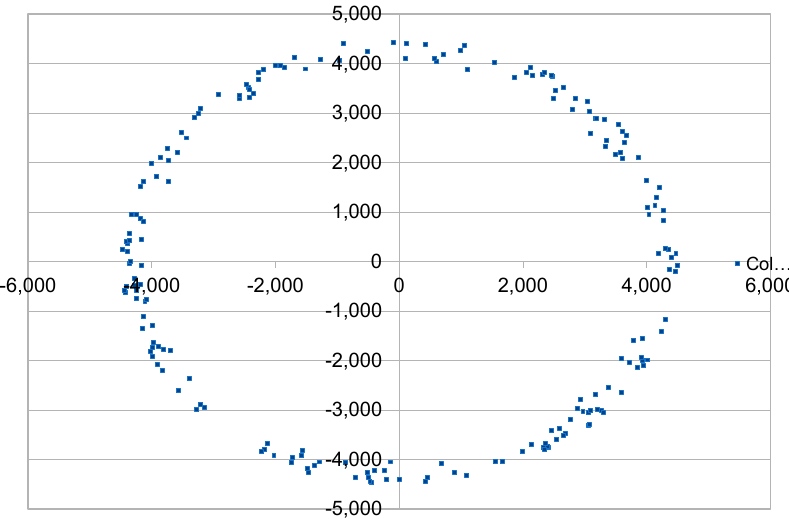
Figure 2. Simulation scenario with disc periphery end node spatial distribution.